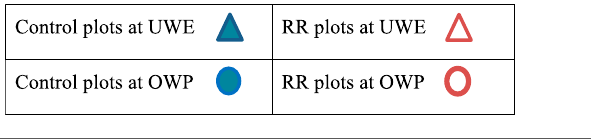
FIGURE 8 | Relationship between total annual biomass production and annualprecipitationatUWEandOWPforControlandRRplots.Valuesshown are mean ± SE; in most cases the error bar is smaller than the